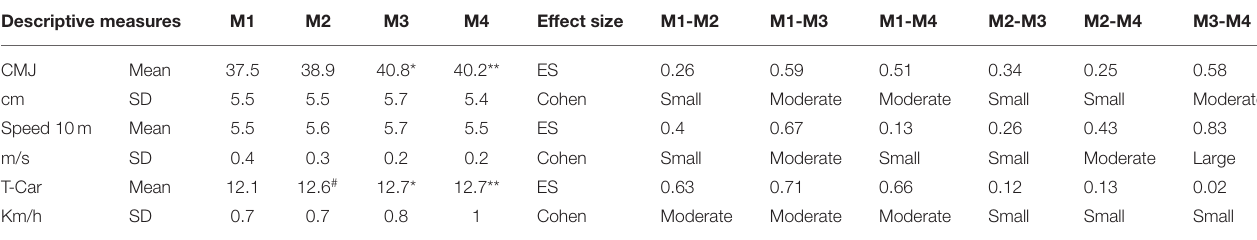
TABLE 2 | Effect size and descriptive measures of biomotor capabilities at different times using Cohen’s d with 95% confidence interval. Descriptive measures